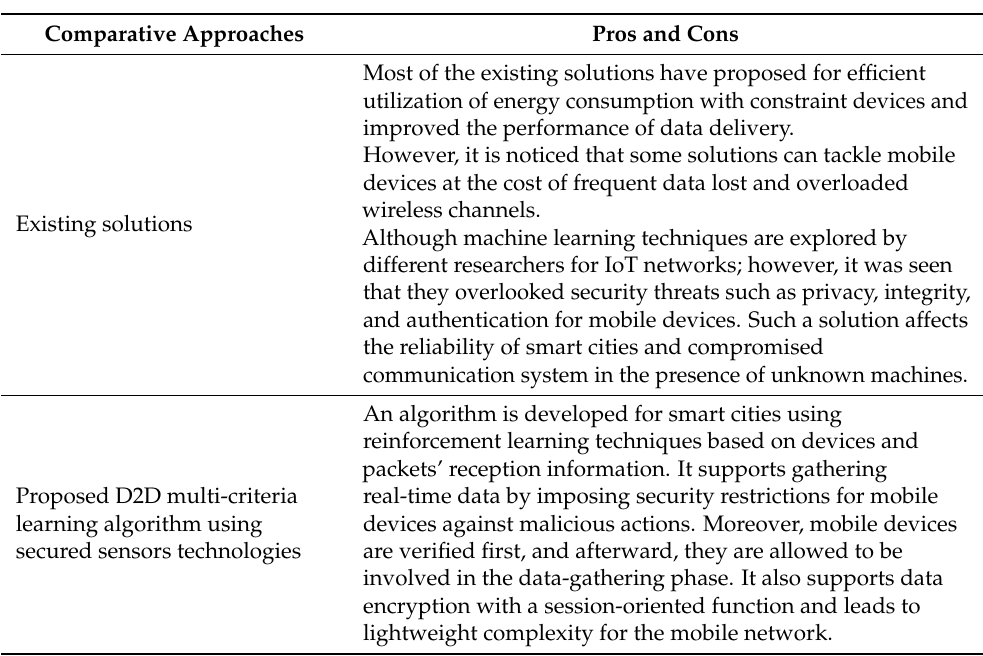
Table 1. Summary of related